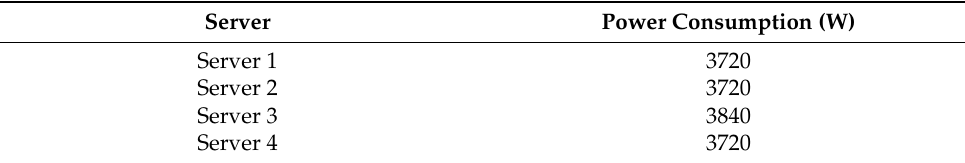
Table 4. Power consumptions of the